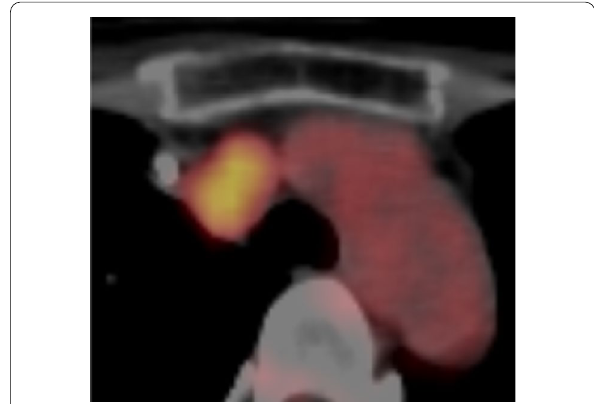
Fig. 2 18 F-FDG-PET/CT. The nodule was the only positive area in the whole body (SUVmax: